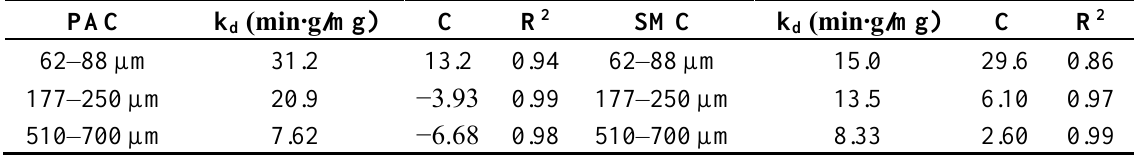
Figure 7. Effect of particle size 62–88 µm (▲), 177–250 µm (●) and 510–700 µm (■), on the adsorption kinetics of 100 mg of PAC ( a ) or SMC ( b ) in 1 L of 60 mg/L BPA-solution. Table 5. Parameters of the Weber-Morris kinetic model for adsorption of BPA on PAC and SMC with different particle